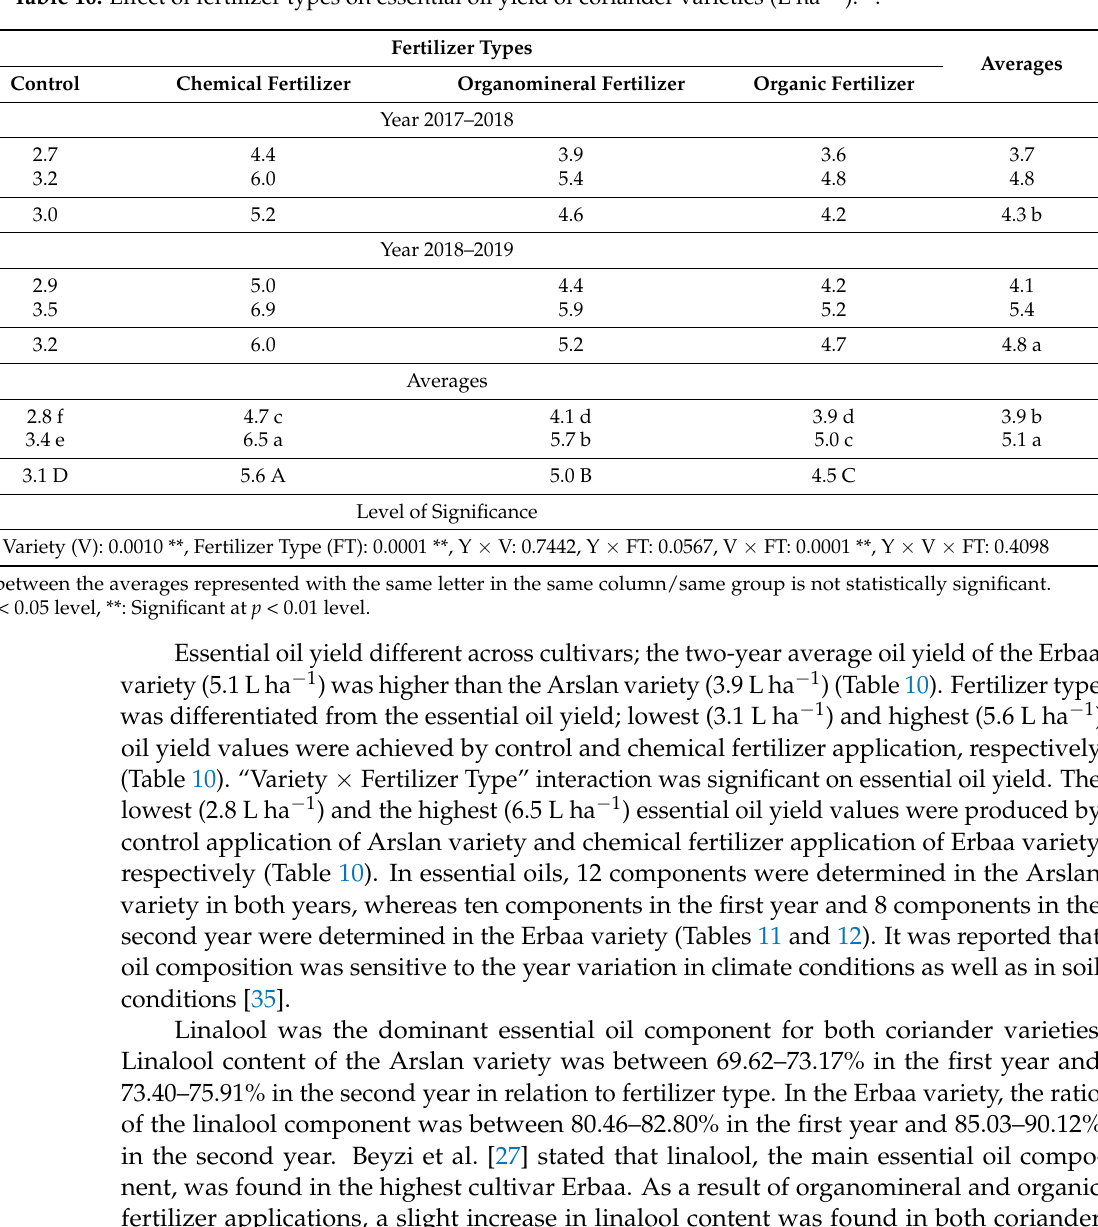
Table 10. Effect of fertilizer types on essential oil yield of coriander varieties (L ha − 1 ). 1